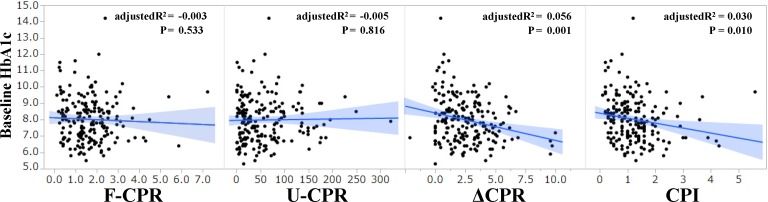
Relationship between baseline HbA1c and indices of insulin secretion.Scatter plots were shown for the relationships between baseline HbA1c and four indices of insulin secretion such as F-CPR, U-CPR, ΔCPR and CPI. Regression lines, adjusted R2 and p value were also shown in the plots.